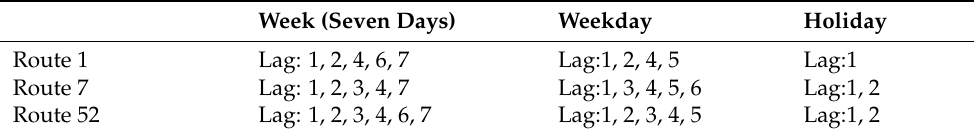
Table 3. Number of lag periods for each route in different time data.